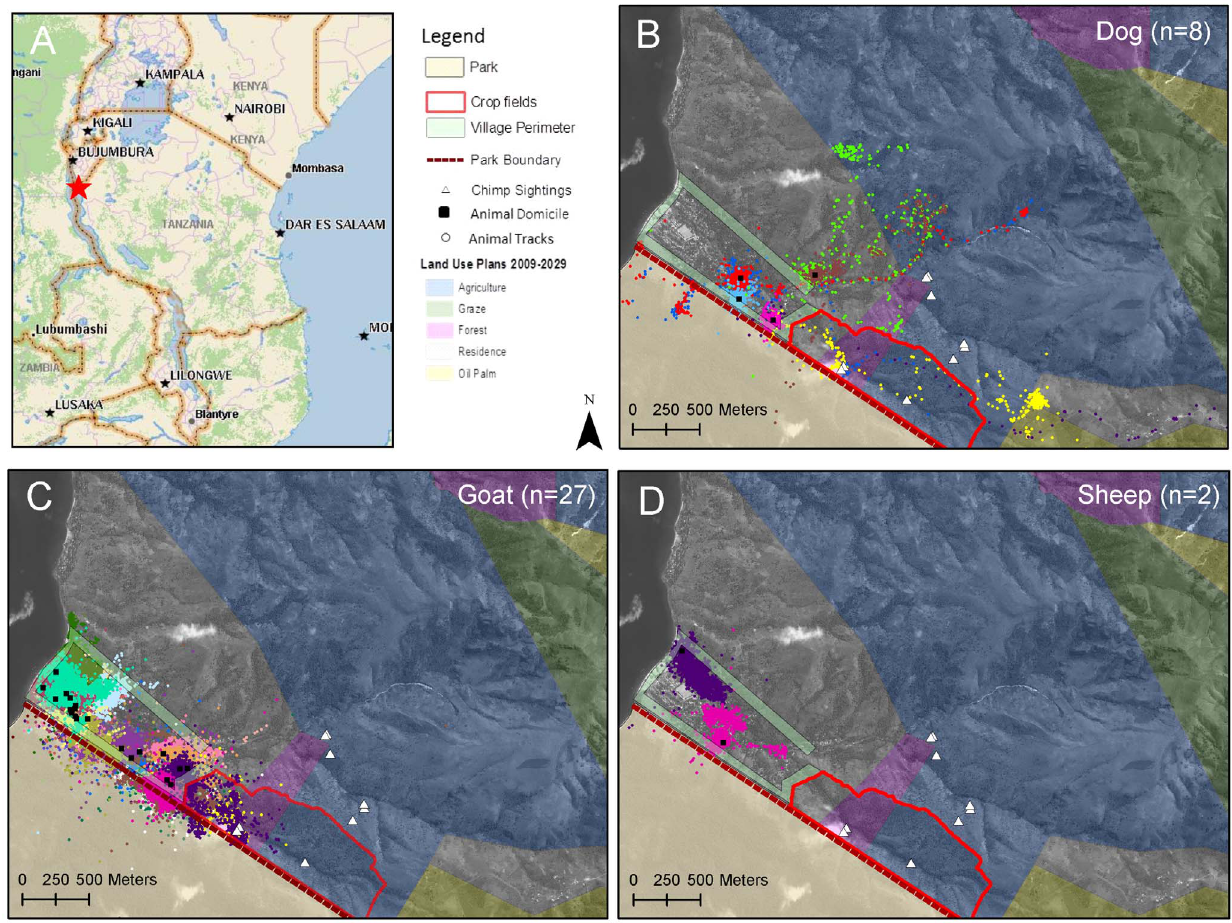
Figure 1. Gombe National Park and Mwamgongo Village, Tanzania. A. Location of study site within Tanzania. B-D Land use plans, chimpanzee sightings, park border, crop-raiding zone, village perimeter and animal mobility tracks of dogs, goats and sheep. Dot colors represent mobility pattern of each individual animal.